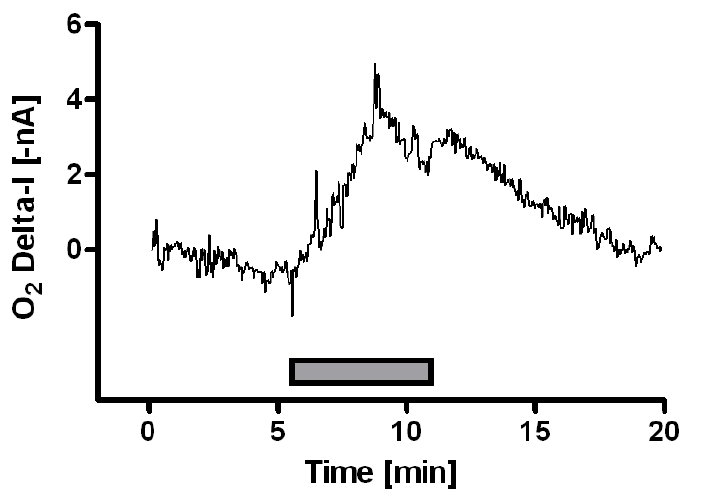
Figure 2. Effect of physiological stimulation on striatal dissolved oxygen. A 5-min